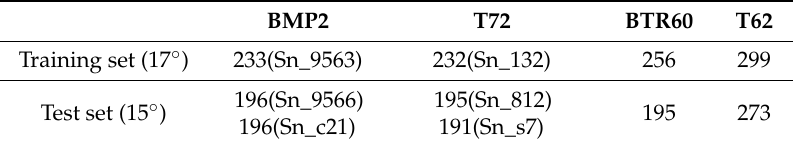
Table 5. Dataset with configuration variance.